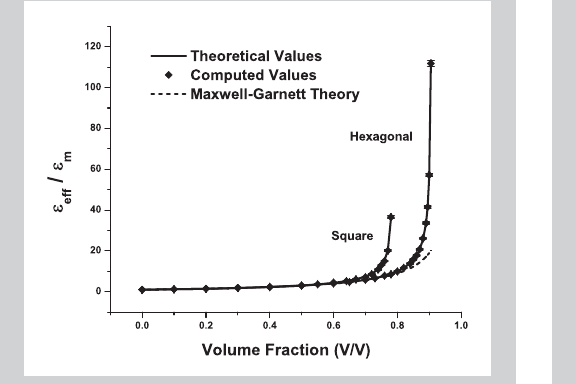
Figure 3: Comparison of the comput- ed values ( Ï ) and the theo- retical values (——) of the effective dielectric constant < e > for the 2d square and eff hexagonal lattices. The dash line (----) represents results obtained from the approxi- mate Maxwell-Garnett the- ory. Figure 4: Comparison of the comput- ed values ( Ï ) and the theo- retical values (——) of the effective dielectric constant < e > for the 3d cubic, BCC eff and FCC lattices. The dash line (----) represents results obtained from the approxi- mate Maxwell-Garnett the-